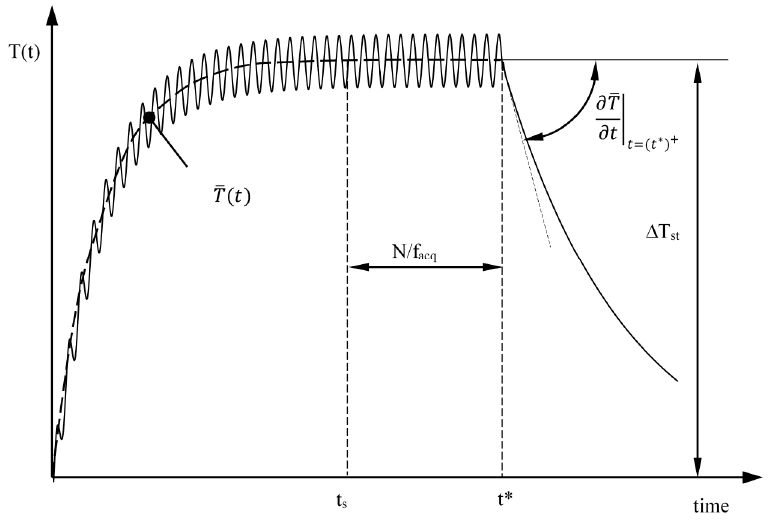
Figure 4. Temperature evolution starting from the beginning of a fatigue test and evaluation of the cooling gradient after stationary conditions are achieved.